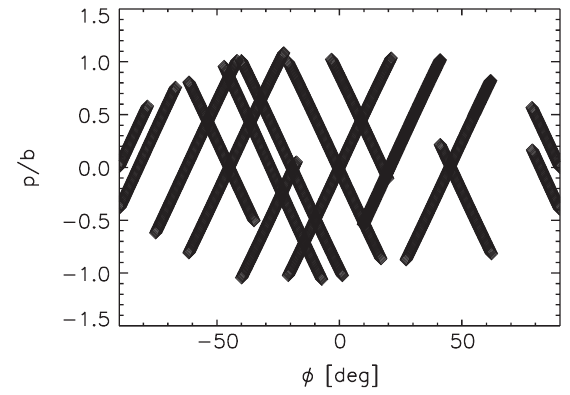
FIG. 3. Experimental coverage in the plane ð (cid:5); p Þ for the tomography diagnostic. b is half the vertical dimension of the beam, p is the impact parameter of the LoS, and (cid:5) is its angle.